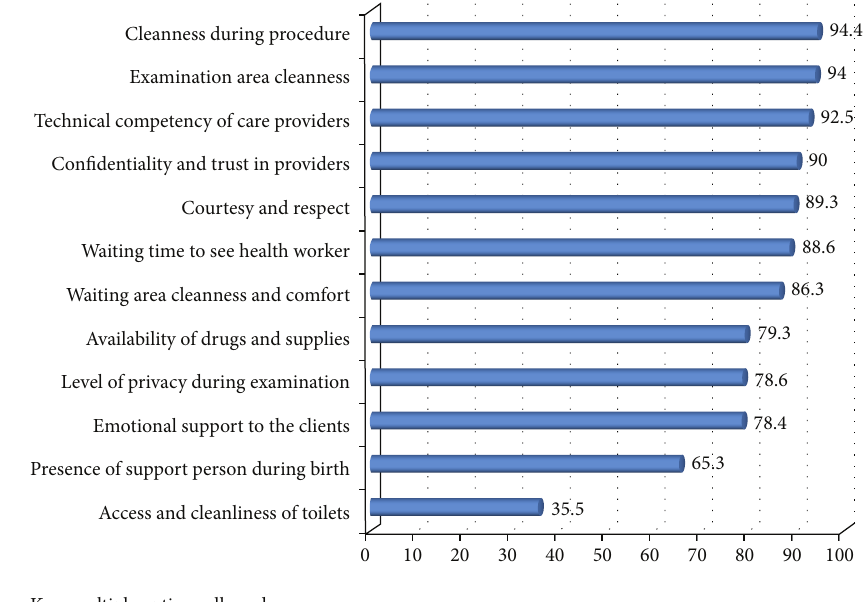
Figure 2: Proportion of client’s satisfaction levels with major dimensions of care in 13 public health facilities of Gamo Gofa